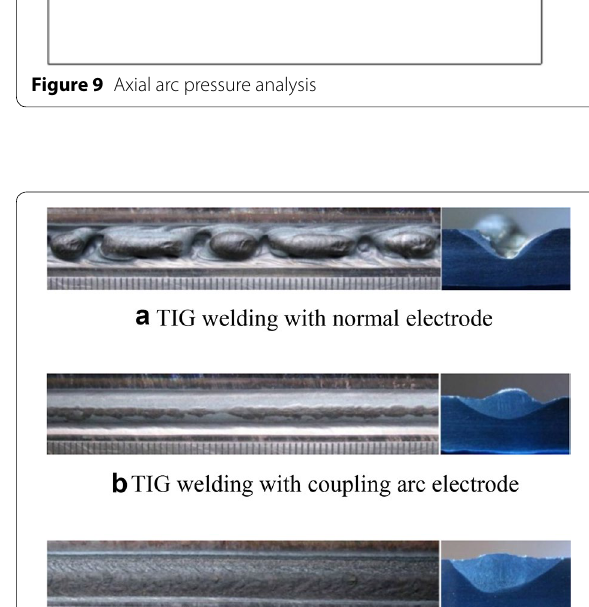
Figure 9 Axial arc pressure analysis